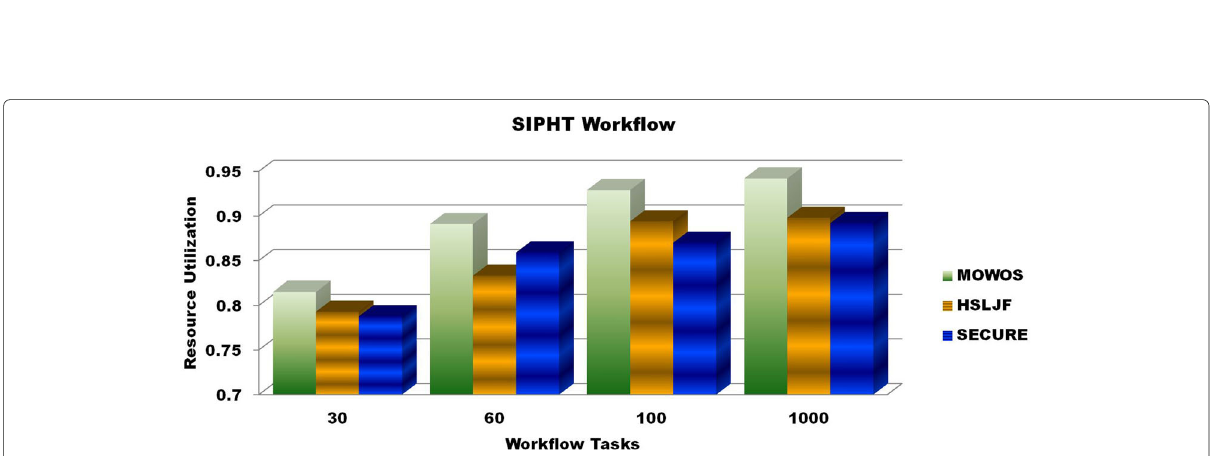
Fig. 15 Comparison of resource utilization using SIPHT workflow